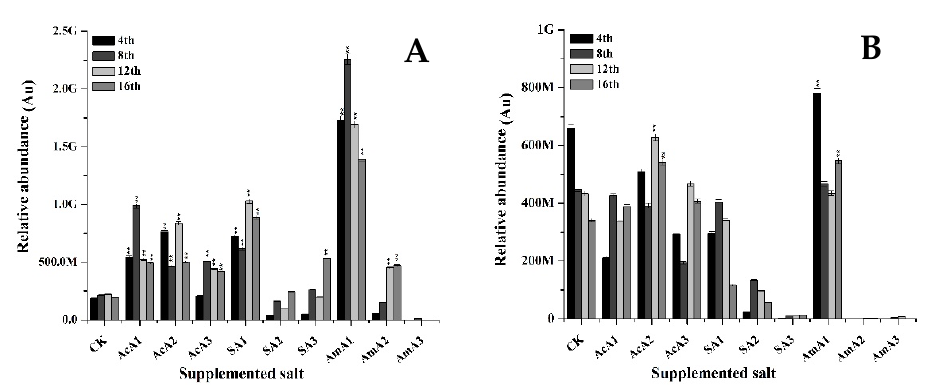
Figure 5. Rubropunctatin value of M. ruber M7 grown over PDA spiked with acetic acid, sodium acetate and ammonium acetate at different concentrations. Acetic acid: AcA1: 0.1%, AcA2: 0.25%, AcA3: 0.5%; Sodium acetate: SA1: 0.1%, SA2: 0.25%, SA3: 0.5%; Ammonium acetate: AmA1: